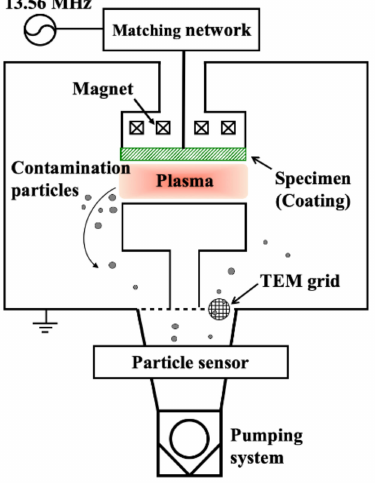
Figure 1. Schematic diagram of capacitively coupled plasma (CCP) etching